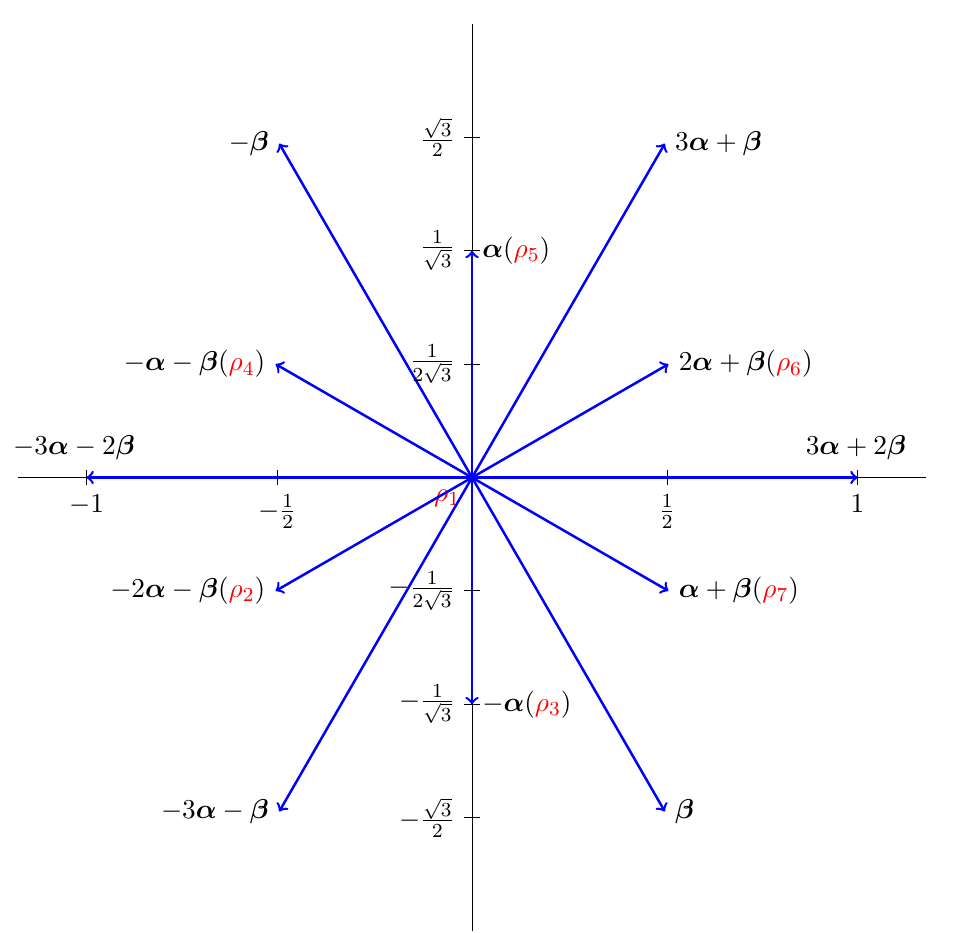
Figure 1 . The G 2 roots and weights of fundamental